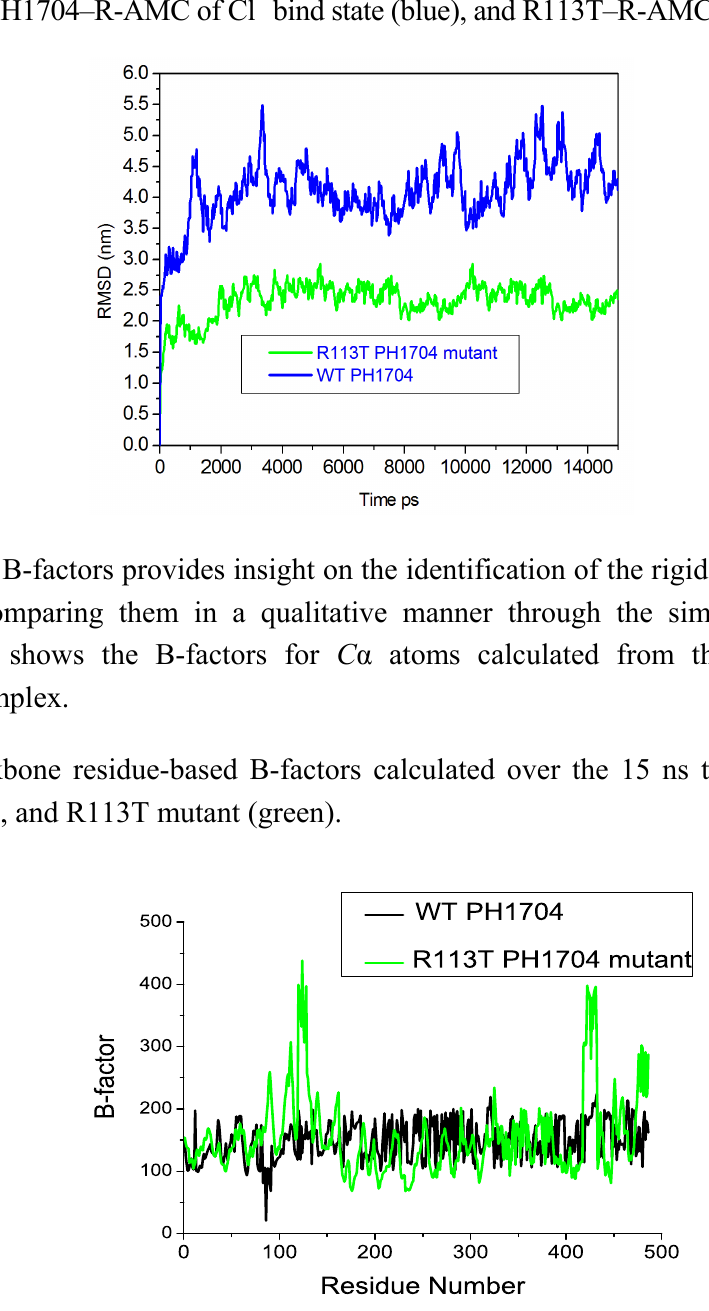
Figure 5. Plot of the RMSD that is experienced by PH1704 over the course of the trajectories for PH1704–R-AMC of Cl − bind state (blue), and R113T–R-AMC mutant (green).